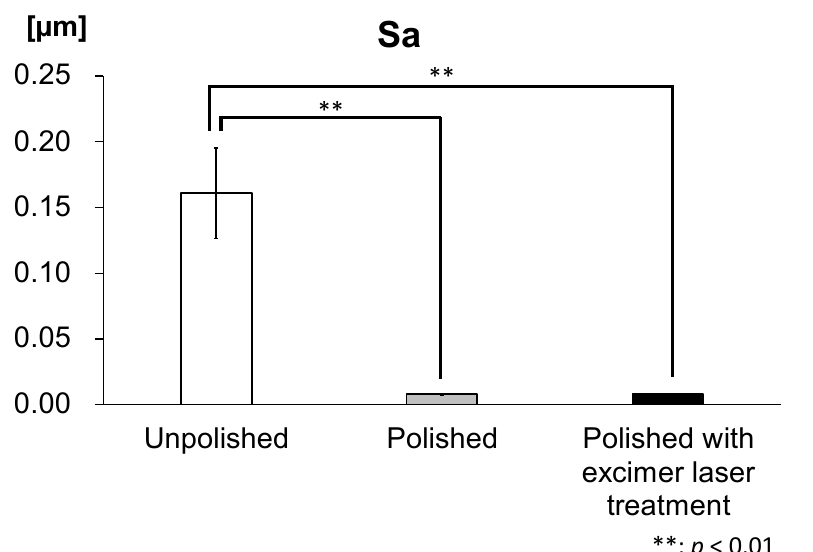
Figure 2. Arithmetic surface roughness (Sa) of zirconia disks. The Sa value was significantly lower in polished disks and in polished disks irradiated with an excimer laser compared to unpolished disks. ( n = 5).